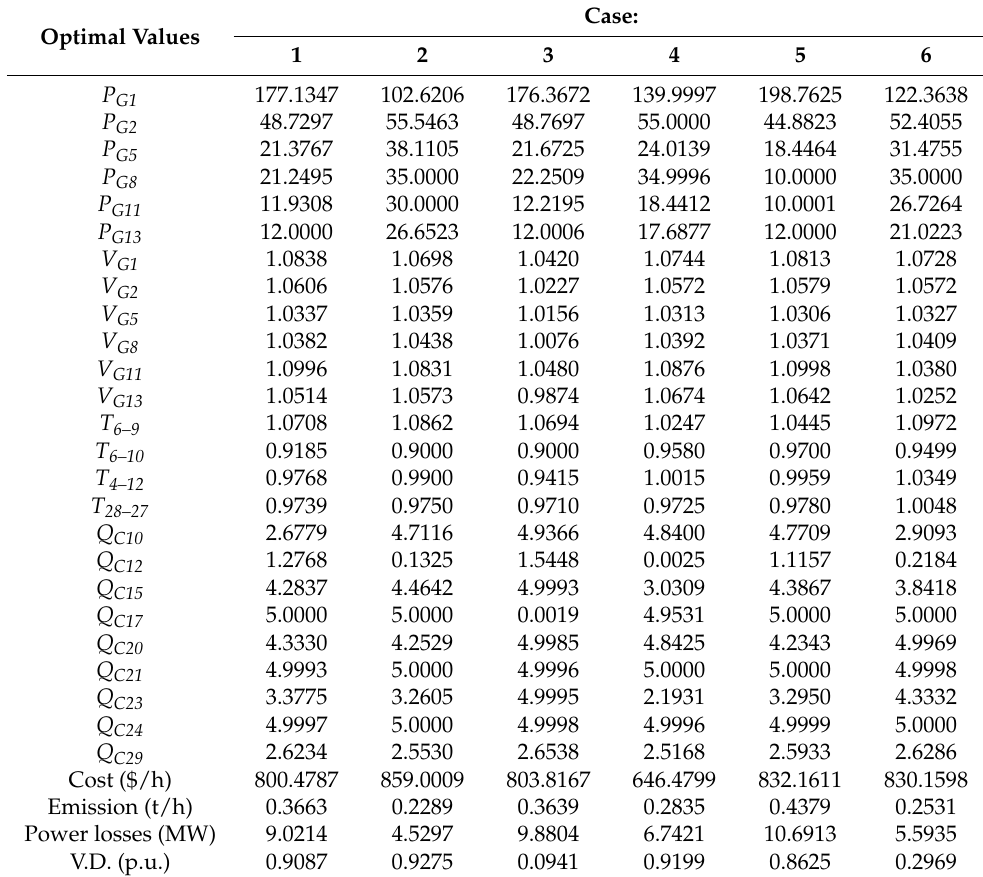
Table 1. ITFWO’s simulation optimal